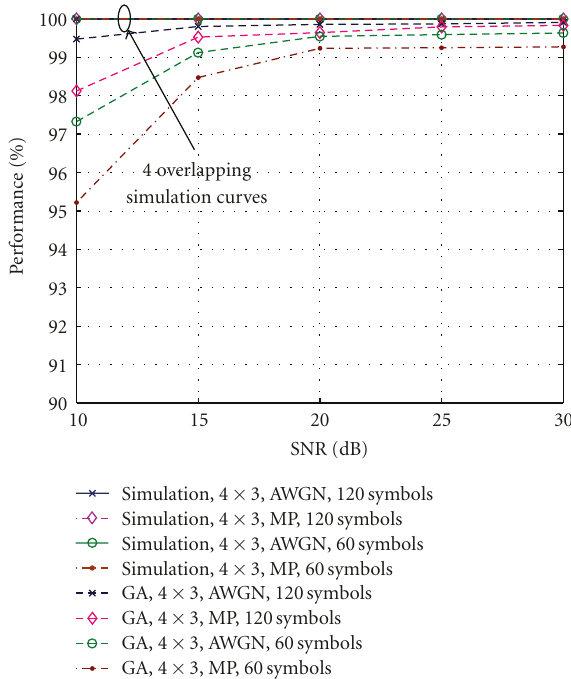
Figure 5: Simulation and Gaussian approximation results for estimating the size of a 4 × 3